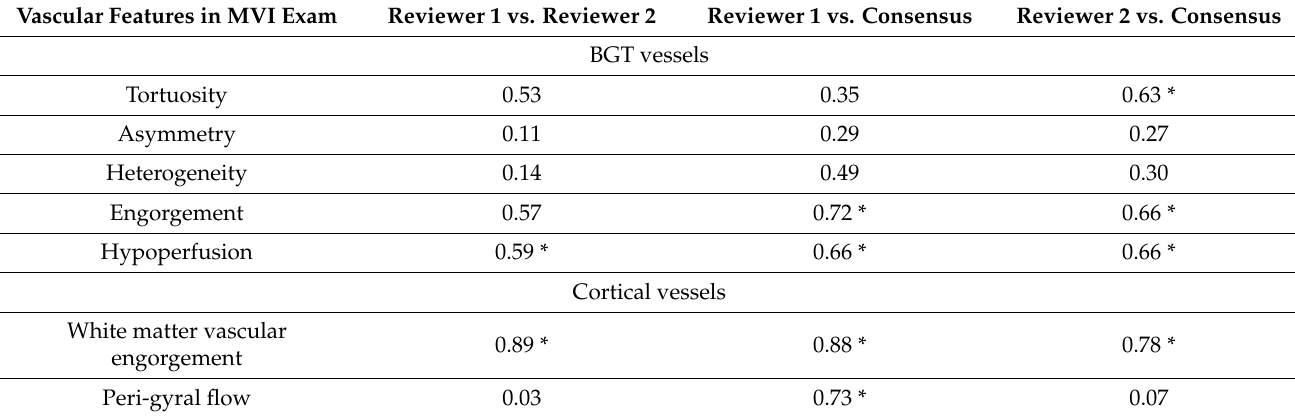
Table 3. Inter-rater reliability for the detection of MVI